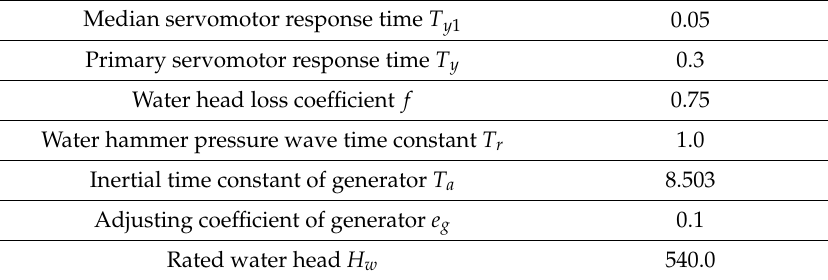
Table 5. Key parameters of the pumped storage unit regulating